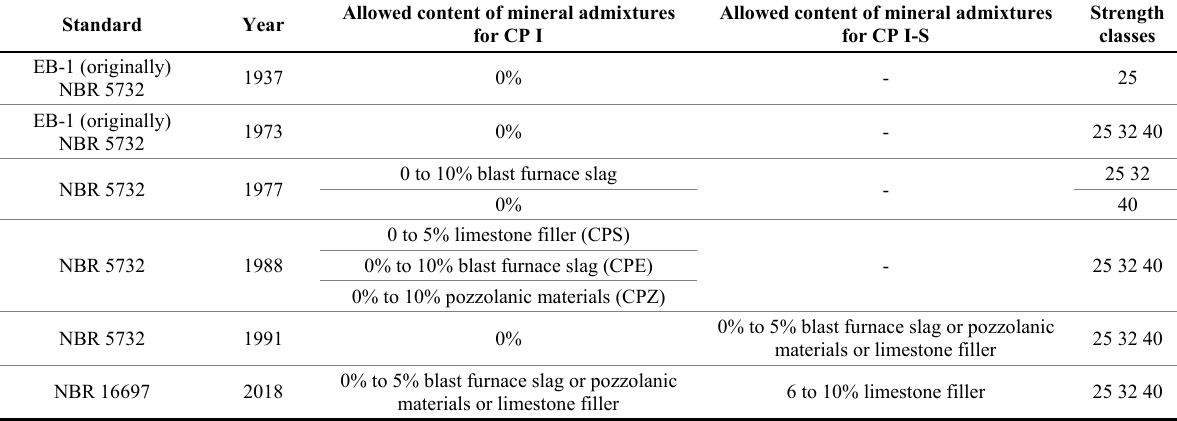
Table 2. Evolution of standardisation of the ordinary Portland cement (CP I and CP I-S) in Brazil, in terms of maximum clinker + calcium sulphate replacement in mass. Allowed content of mineral admixtures Allowed content of mineral admixtures Strength Standard Year for CP I for CP I-S classes